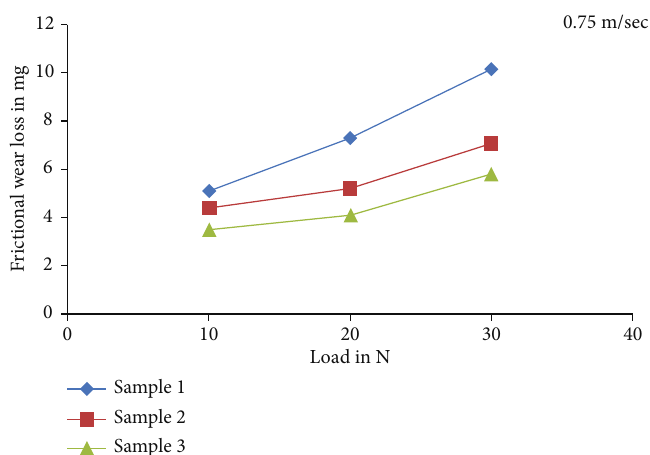
Figure 5: Frictional wear loss of silver hybrid nanocomposite.